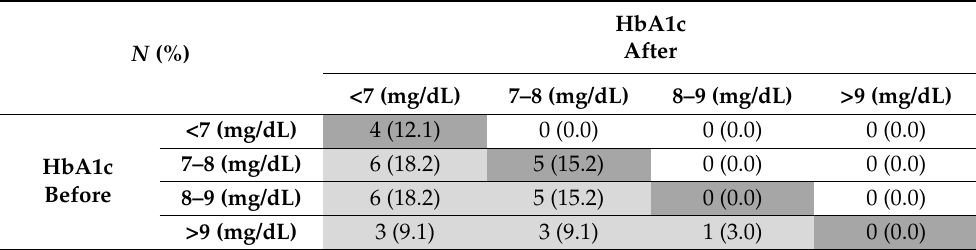
Table cells with subjects having the same, lower or higher HbA1c levels after EVLCD compared to before EVLCD are filled in dark gray, light gray and white, respectively. Total number of subjects = 33.